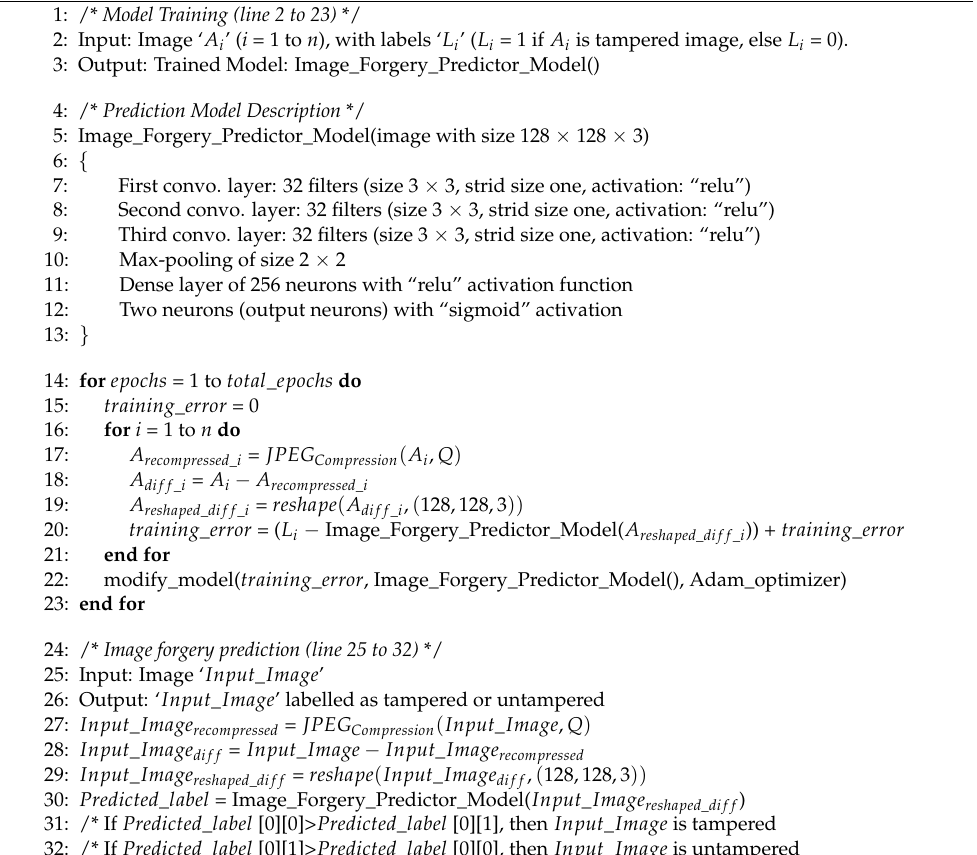
Algorithm 1: Working of the proposed technique for the image forgery